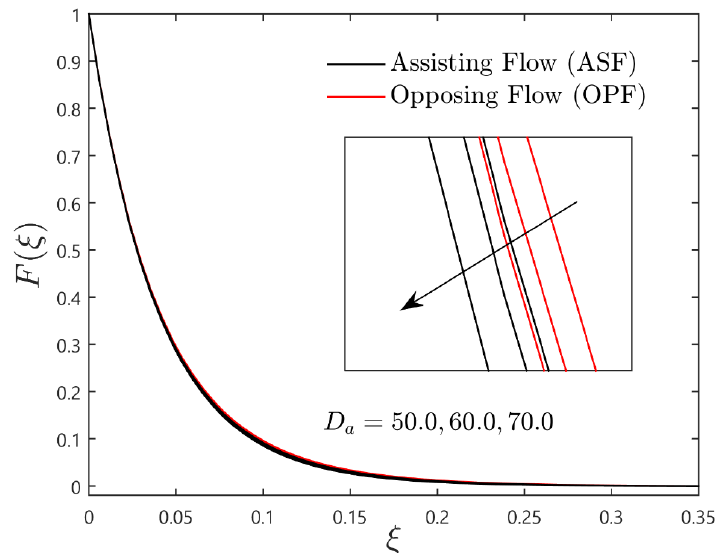
Figure 8. Concentration profile for the case of ASF and OPF due to variations in the values of D a